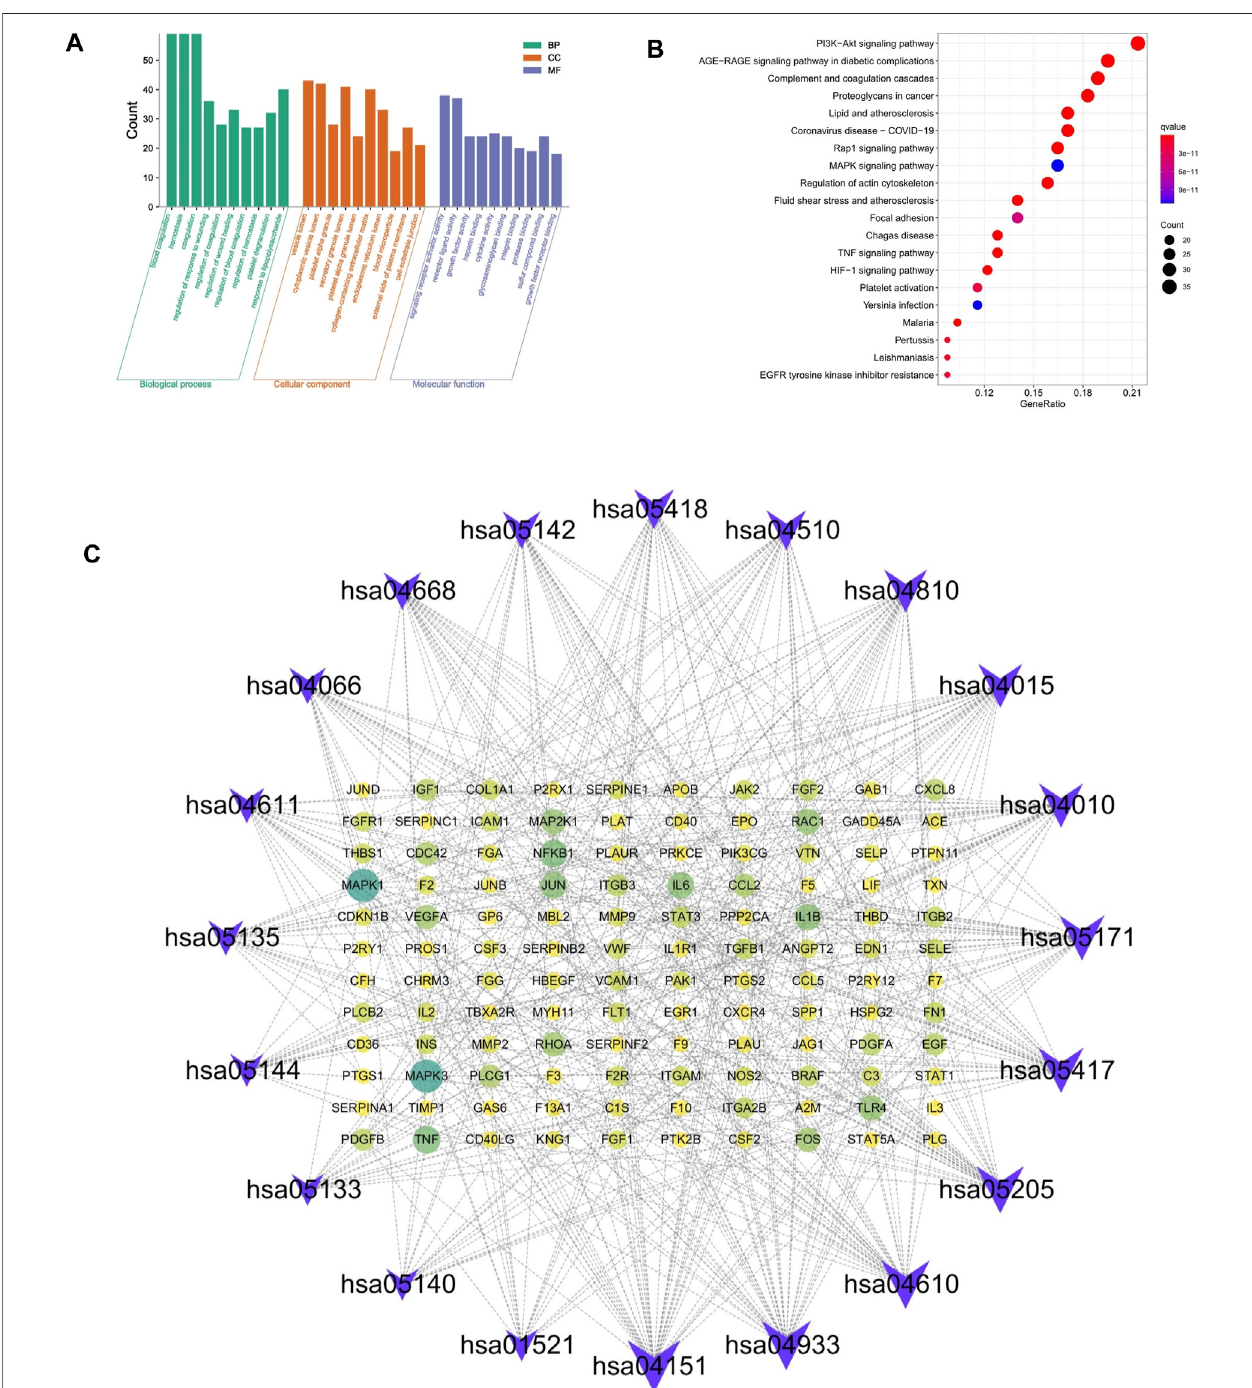
FIGURE 4 | (A) The GO and KEGG pathway enrichment. (B) Analysis of 20 therapeutic signaling pathways of hirudin on myocardial hypertrophy. (C) The purple V shape represents the signaling pathway, the yellow circle represents the target, and the size of the shape and the depth of the color represent more intersections.